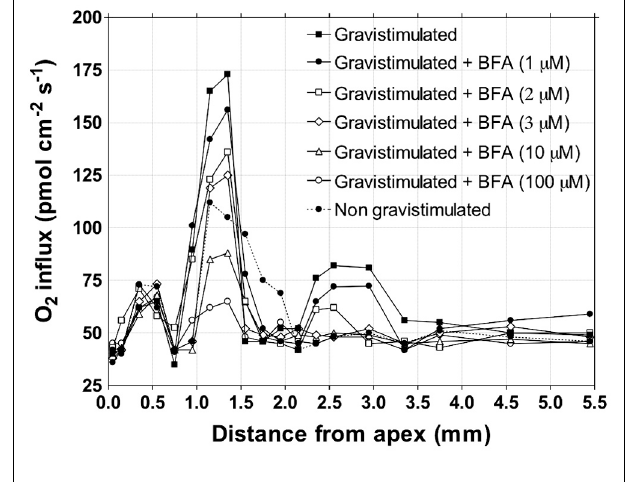
FIGURE 6 | BFA inhibits oxygen influx peak into the transition zone. Effect of different concentrations of BFA on the profiles of the oxygen influx for the upper side in maize roots growing vertically for 5 min after gravistimulation (elicited by rotating the chamber 90 ◦ until the root was horizontal.Values are means, n = 15. Oxygen fluxes were measured with a vibrating oxygen-selective microelectrode following the method described in Mancuso etal.